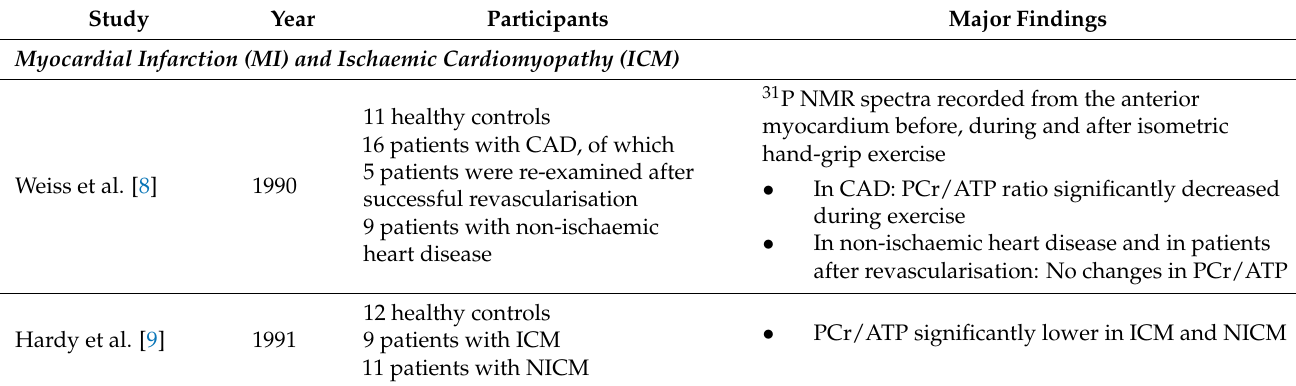
Table 1. Table of studies included in the systematic review and their